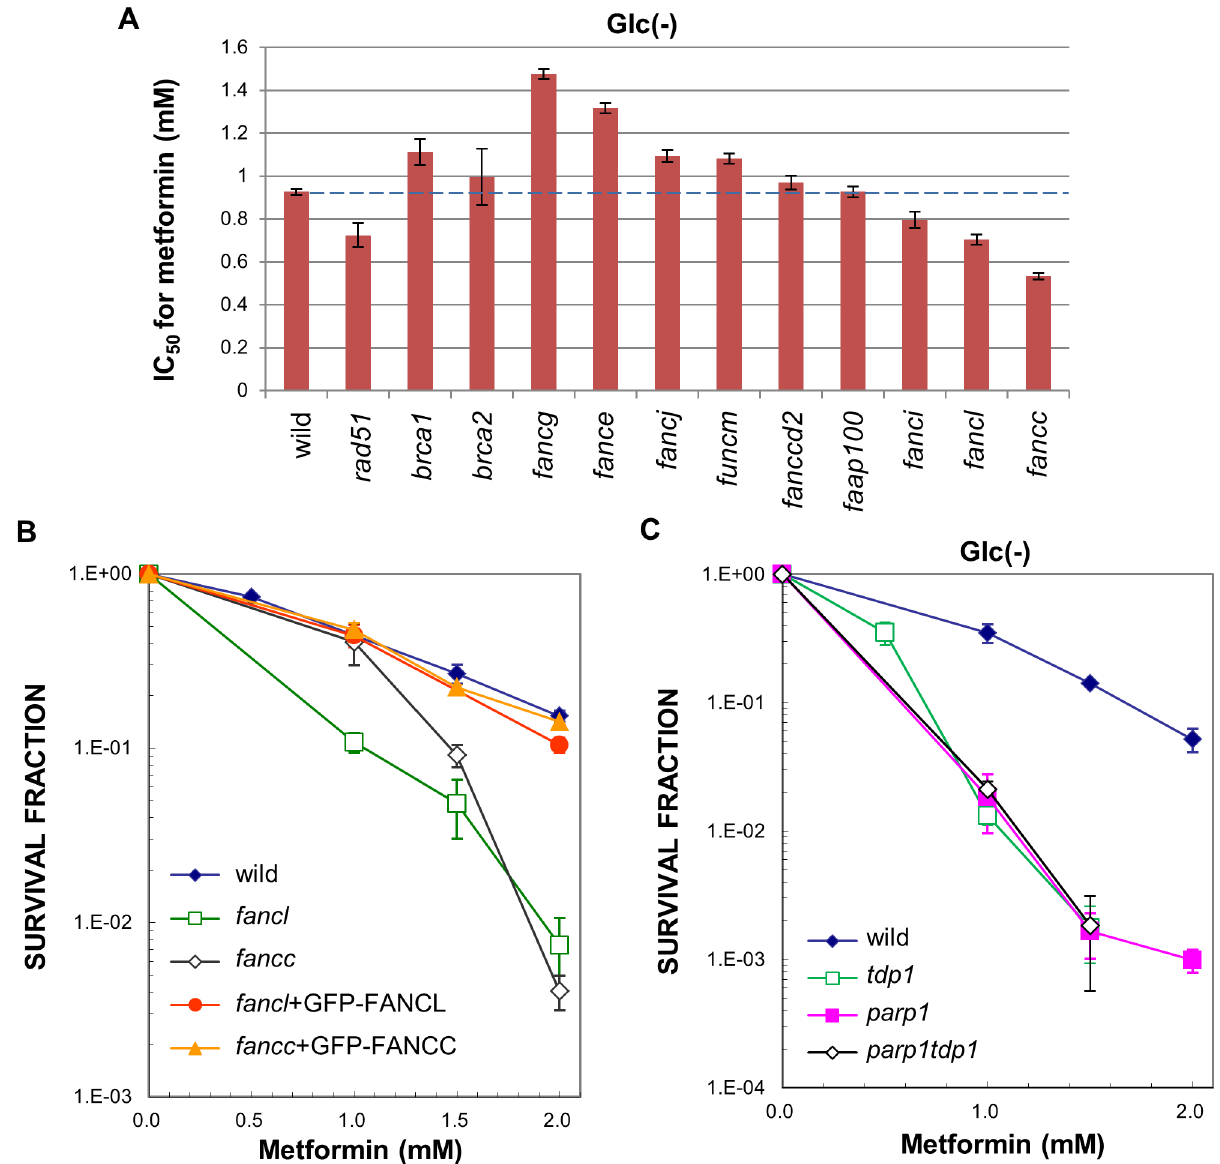
Fig 2. FA pathway-related proteins involved in removing DNA lesions induced by metformin. (A) Histograms of the IC 50 values of metformin in wild-typecells and cell lines deficientin variousFANC-related proteins. Cells were treated with metformin under glucose- depleted conditionsfor 24 h and coloniesformed on completemedia. All data represent IC 50 values ± 95% confidenceintervals; (B) The toxicity of metformin to cells deficient in the FANCC or FANCL protein and deficient cell lines stably expressingthe indicatedtransgenes. Data represent the mean ± S.D.; (C) The toxicity of metformin to cells deficientin the TDP1 or PARP1 protein and cells simultaneously deficientin both TDP1 and PARP1 proteins. Data represent the means ± S.D.